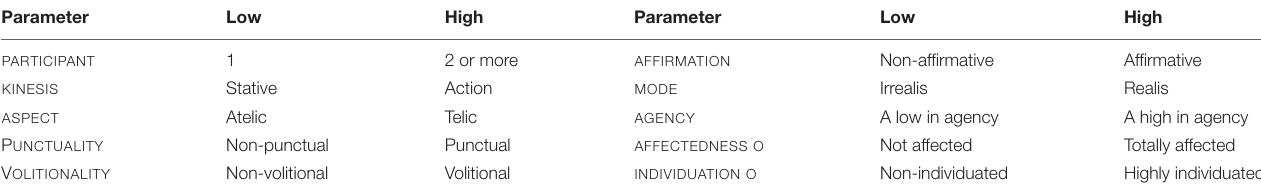
TABLE 1 | Transitivity parameters from Hopper and Thompson